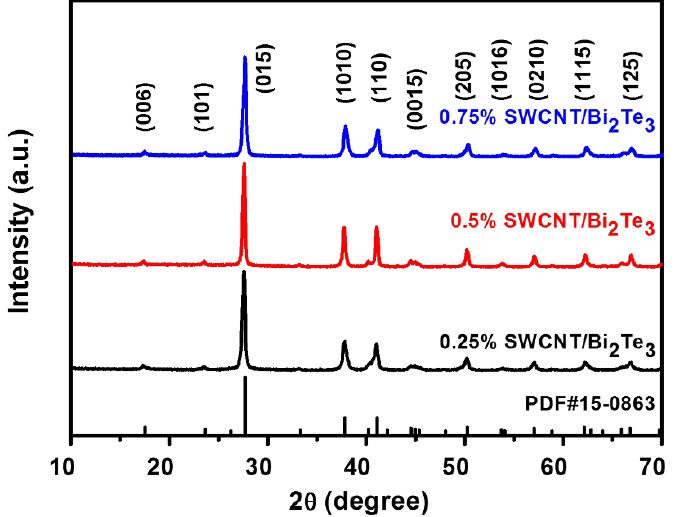
Figure 2. XRD patterns of the SWCNT/Bi 2 Te 3 composite powders with different contents of SWCNTs from 0.25 to 0.75 wt %.